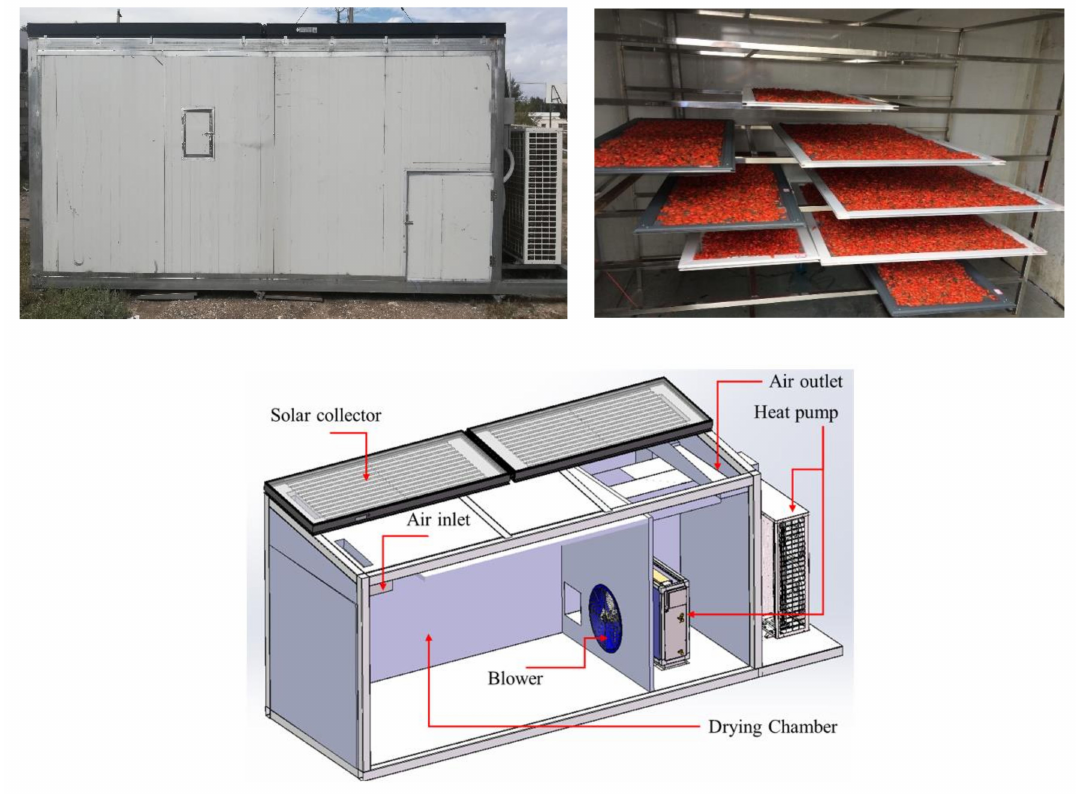
Figure 3. Photos and schematic diagram of the drying system.